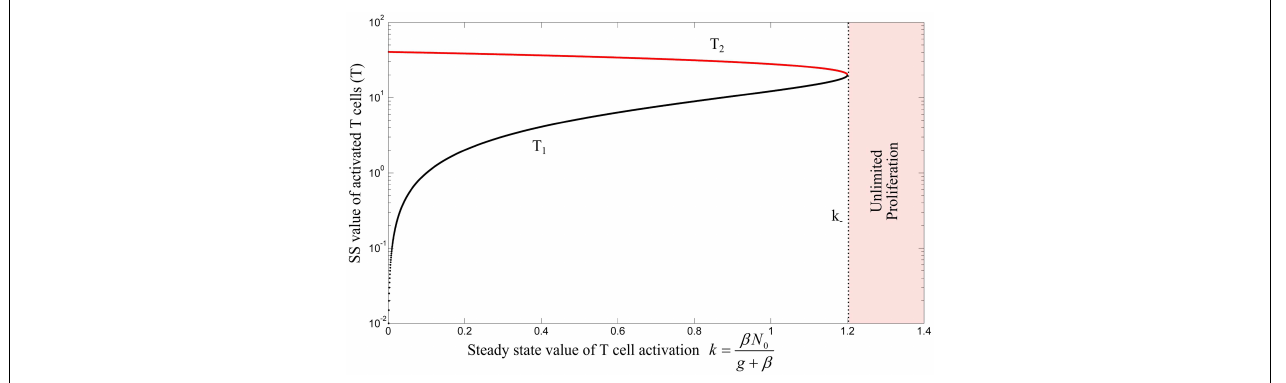
FIGUREA1 | Bifurcation diagram of model (A63) with Hill-function parameters n = 2 and h = 0.5 by treating k as bifurcation parameter . Stable and unstable equilibrium points are shown by black and red lines, respectively. For k > k − , the immune response enters the regime of unlimited proliferation.The unstable negative equilibrium point is omitted in this figure.